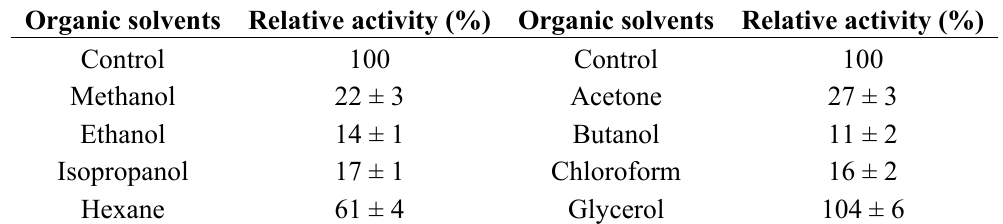
Table 3. Influence of various organic solvents on the activity of rProROL. Enzyme samples were mixed with solvents (50%, v / v ) and incubated for 6 h in a rotary shaker set at 160 rpm and 25 °C, prior to determining the residual activity. The activity was measured with a pH-stat (Metrohm) and using olive oil as substrate at pH 9.0, 40 °C. All measurements were carried out in triplicate.